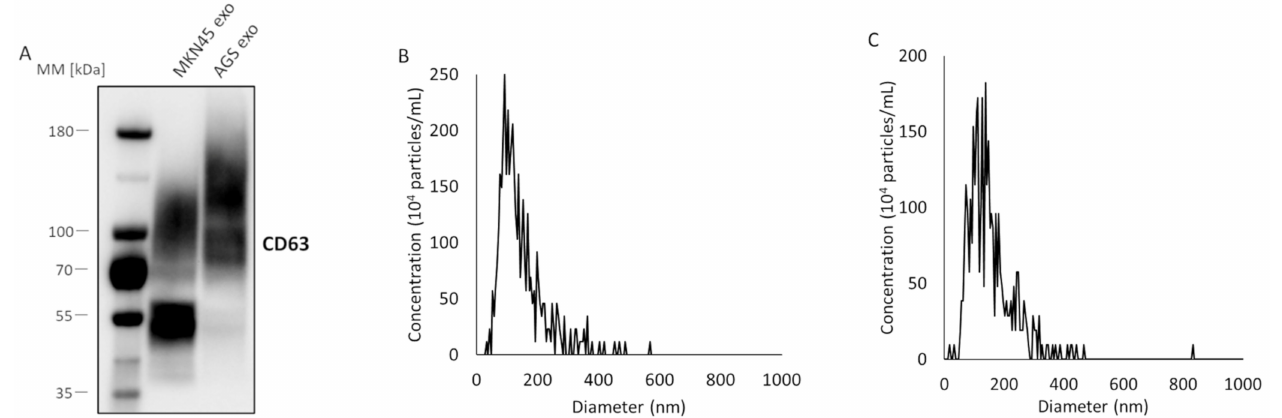
Figure 2. Characterization of exosomes isolated from the supernatant of cultured gastric cancer cells using a combination of a polymer precipitation method and ultra-filtration method. ( A ) Western blotting of an exosome-marker protein, CD63, for exosomes in the supernatant of MKN45 and AGS cells. The molecular mass of CD63 is 40–50 kDa, and CD63 forms a dimer and is glycosylated. ( B ) Nanoparticle tracking analysis for exosomes in the supernatant of AGS cells. The peak value was around 93 nm. ( C ) Nanoparticle tracking analysis for exosomes in the supernatant of MKN45 cells. The peak value was around 138